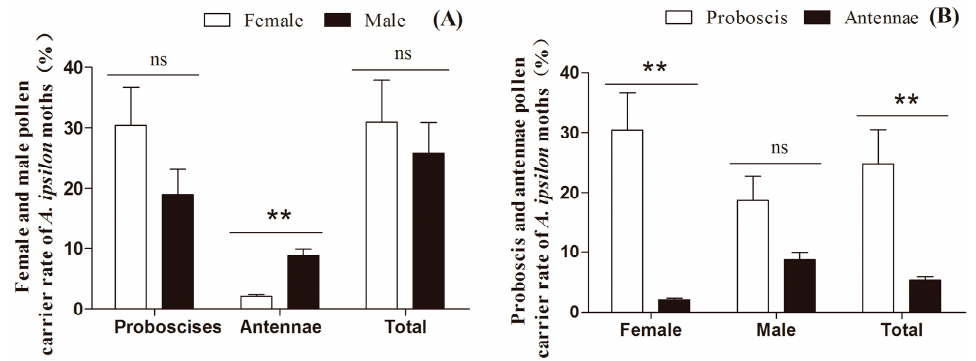
Figure 2. ( A ) Frequencies of pollen deposition on female and male proboscises, antennae and total (proboscis and antennae) of A. ipsilon moths; ( B ) Frequencies of pollen deposition on proboscis and antennae of female, male and total (female and male) of A. ipsilon moths. Double asterisks ( ** ) indicates there was significant difference at the 1% level as determined by a t -test, and ns indicates there was no significant difference.